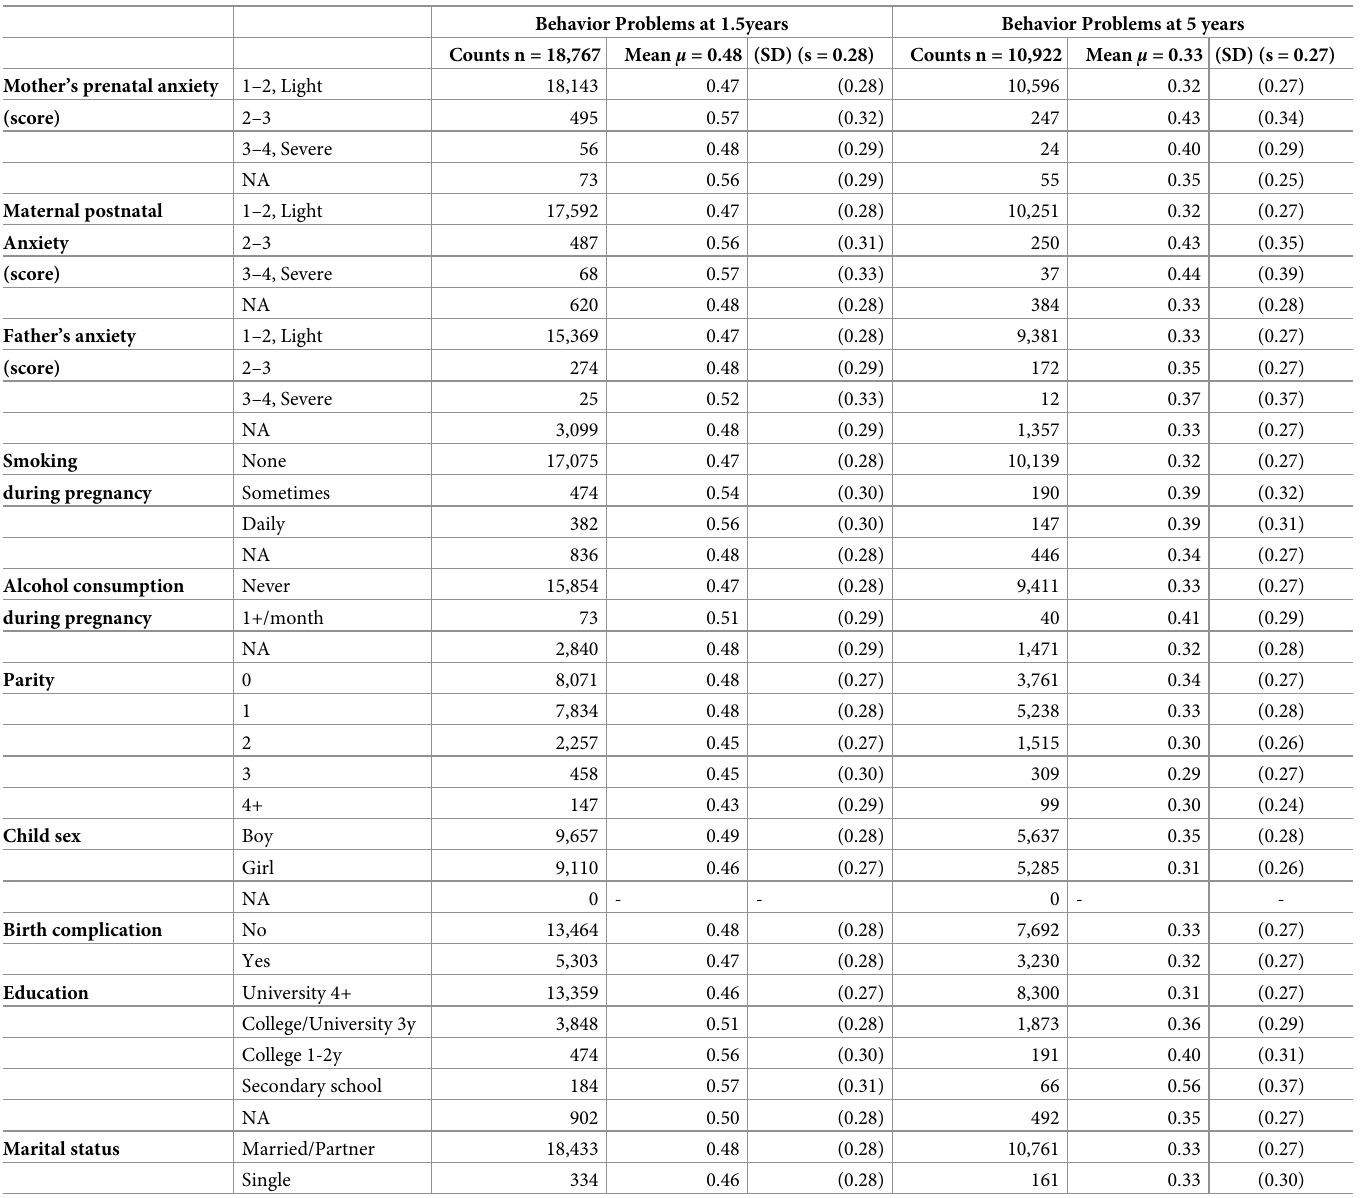
Table 2. Characteristics of sibling